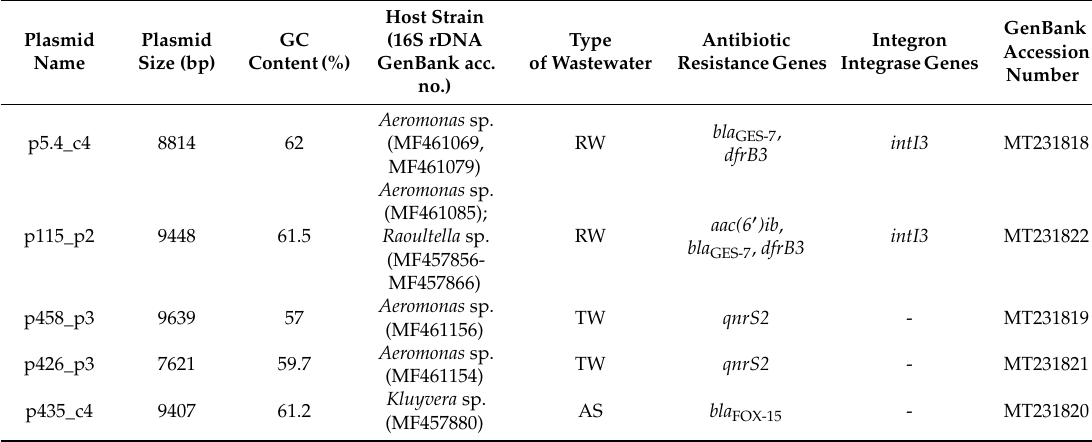
Figure 1. Linear maps showing the genetic structure of the circular IncQ-3 plasmids identified in the study. Genes assigned to specific modules are highlighted in different colors: Yellow—mobilization to plasmid transfer module, red—replication module, green—antibiotic resistance genes, blue—integrase. Red and yellow dots represent oriV and oriT , respectively. Comparative analyses were performed using 90% nucleotide sequence identity threshold (gray areas connecting DNA regions). Table 1. General information concerning the IncQ-3 plasmids identified in this study.